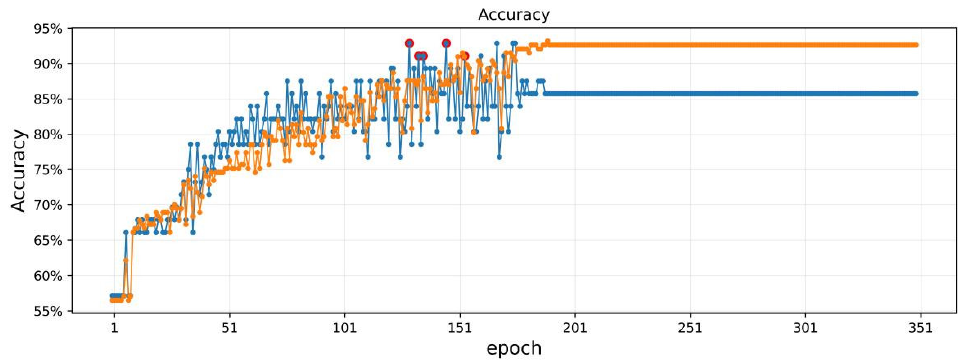
Figure 11. Classification results of japonica rice GD by CapsNets model. Epoch was the number of training cycles of the model, and the yellow line and blue line represent the accuracy of the training and test datasets, respectively.